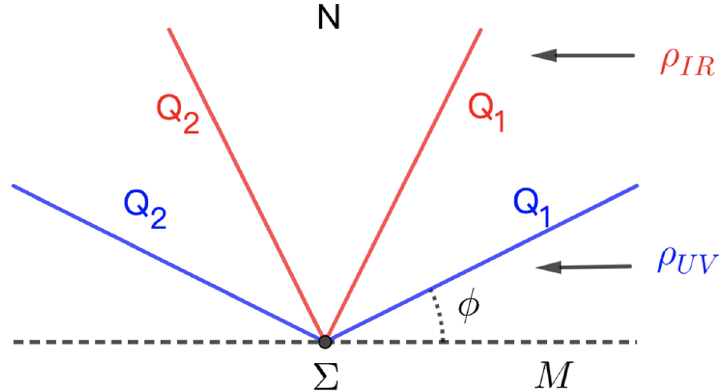
Figure 2 . UV Planck brane (blue) and IR Planck brane (red). The smaller the tension T = ( d − 1) tanh ρ is, the deeper the brane bends into the bulk (IR). Thus ρ decreases under RG